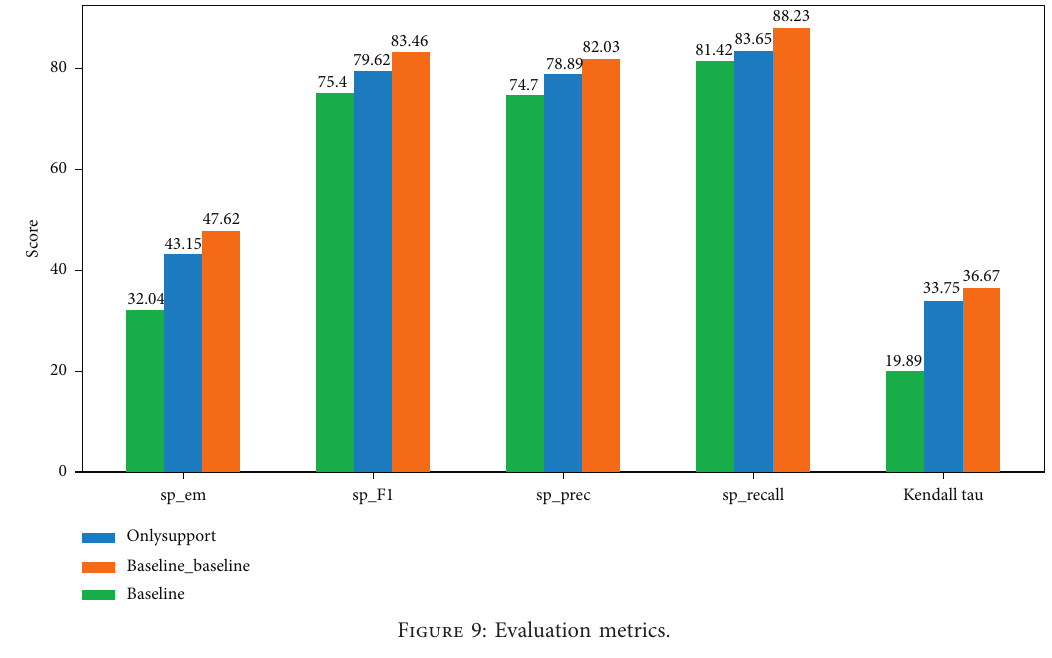
Figure 9: Evaluation